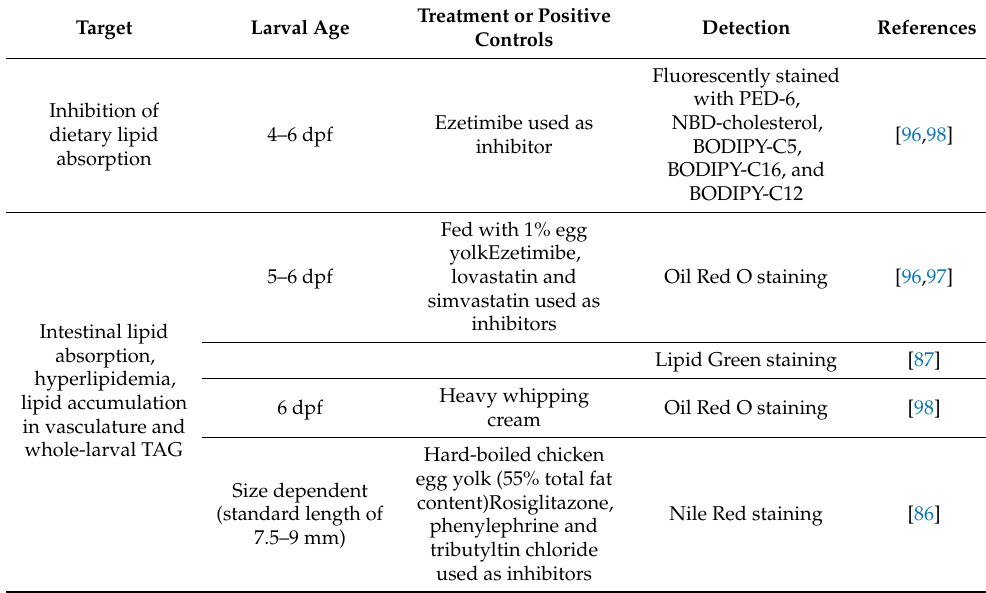
Table 3. Methods suitable for modelling obesity using wild-type zebrafish